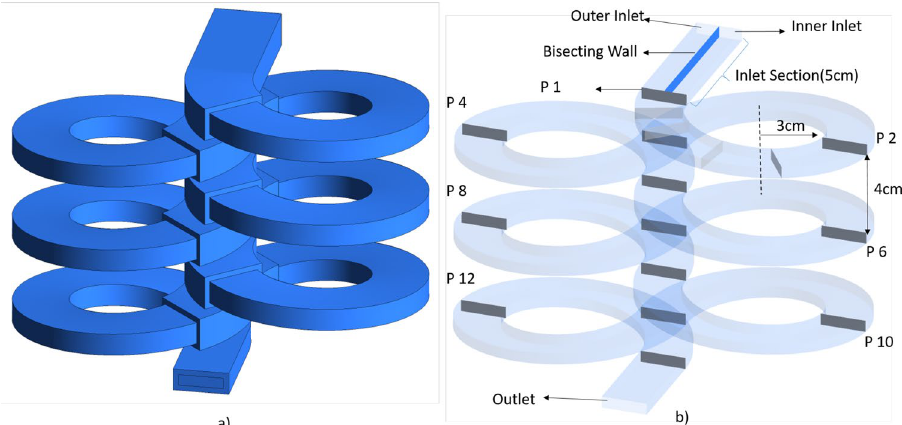
Figure 2. Geometry of the infinity reactor: ( a ) outside view showing the modular design, and ( b ) flow path highlighting the axial planes used for post-processing. Images used courtesy of ANSYS,